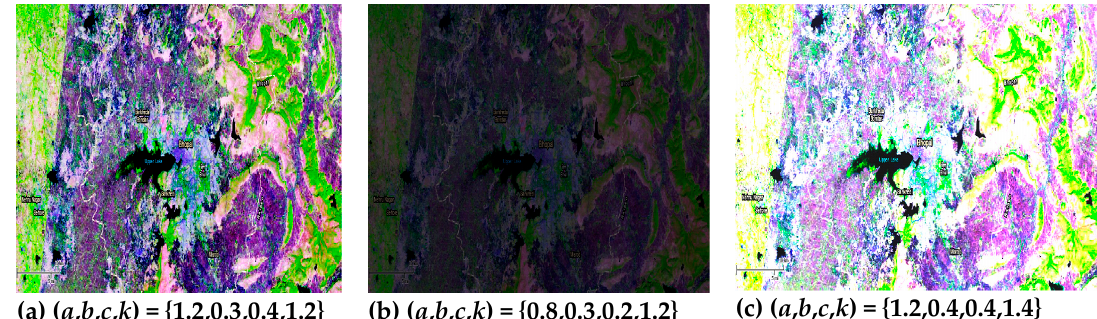
Figure 4. Optimization results for sample image ( a ) Bat optimized contrast stretching ( b ) under-stretched image ( c ) over-stretched image.